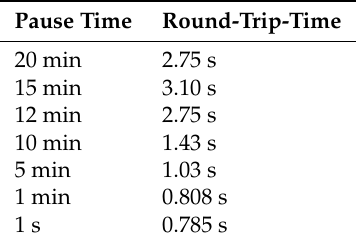
Table 13. Postman Test Settings.